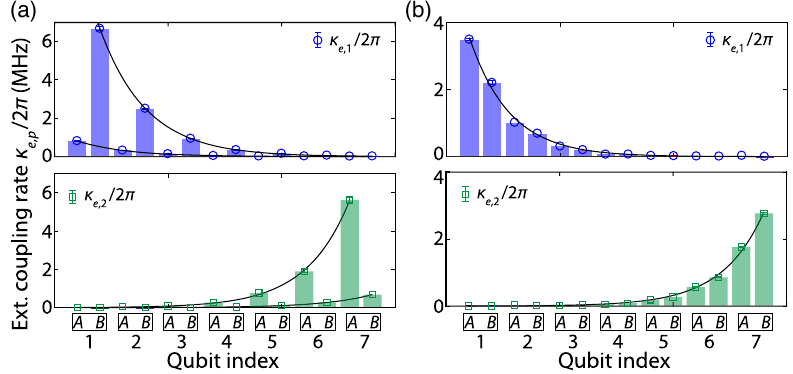
FIG. 13. (a) Upper (lower) plots: external coupling rate of the qubit-photon bound states to port 1 (2) at 6.72 GHz in the middle band gap. Exponential fit (black curve) on the data gives the localization length of ξ ¼ 2 . (b) Upper (lower) plots: external coupling rate of the qubit-photon bound states to port 1 (2) at 7.485 GHz in the upper band gap. Exponential fit (black curve) on the data gives the localization length of ξ ¼ 1 . 8 . The localization lengths are represented in units of lattice constant. For all panels, the error bars show 95% confidence interval and are removed on data points whose error is smaller than the marker size.